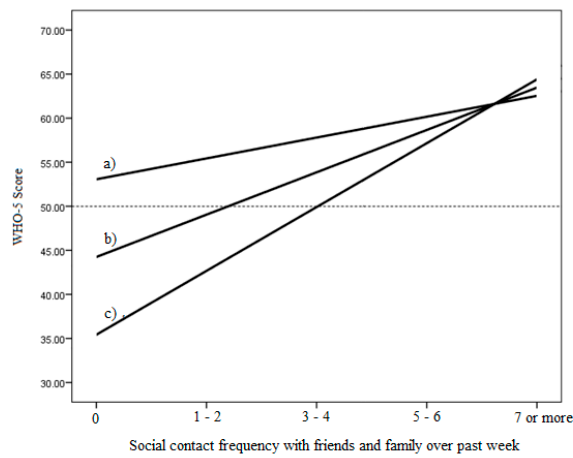
Figure 1. Simple slopes graph depicting conditional relationship between social contact frequency and subjective wellbeing in the last seven days: (a) at 1 standard deviation above the mean; (b) at the mean; (c) at 1 standard deviation below the mean of nearby nature. The dashed horizontal line depicts the threshold below which wellbeing is considered low [105].